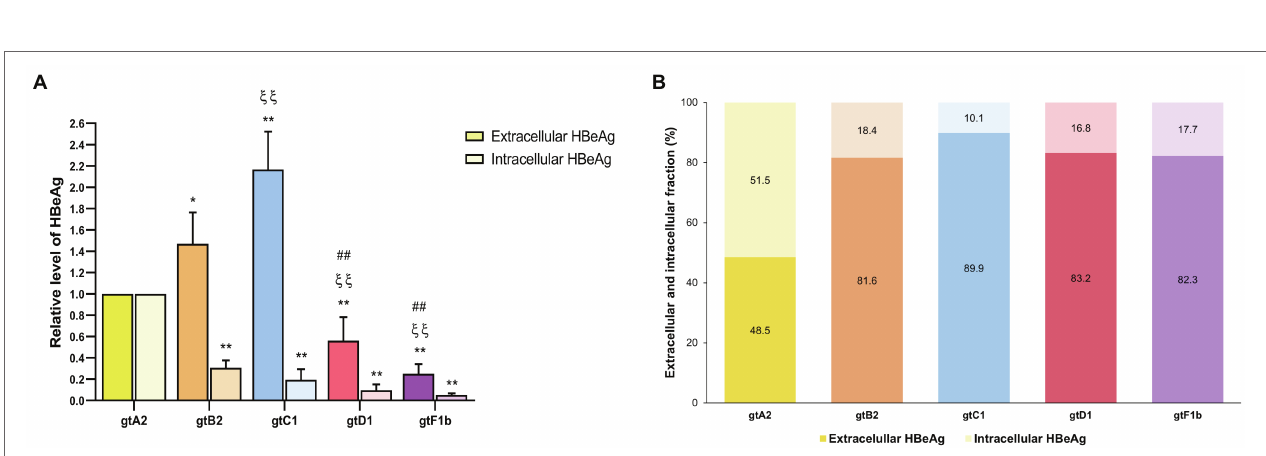
FIGURE 6 | Analysis of intracellular and secreted HBeAg levels across genotypes. HuH-7 cells were transfected with linear full-length HBV genomes of genotypes A2, B2, C1, D1, and F1b. Three days post-transfection, cells and culture supernatants were harvested, and intra- and extracellular levels of HBeAg were determined by ECLIA (A) . Extracellular/intracellular HBeAg ratio (B) . Shown values represent the mean ± standard deviation of three independent experiments. *: Intracellular or extracellular difference in relation to genotype A2, ξ : Intracellular or extracellular difference in relation to genotype B2, and #: Intracellular or extracellular difference in relation to genotype gtC1. One symbol: p < 0.005 and two symbols: p <